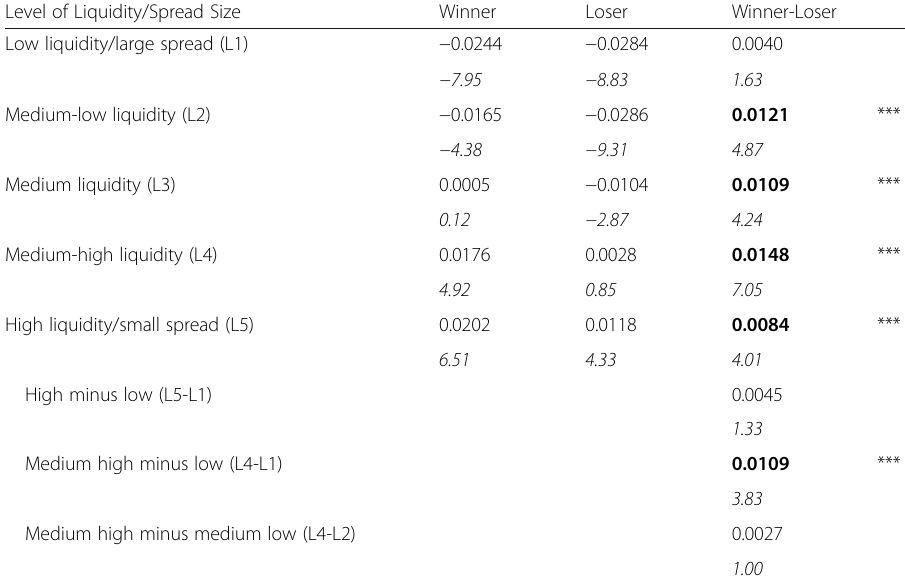
Table 7 Returns of Liquidity-Momentum Portfolios Level of Liquidity/Spread Size Winner